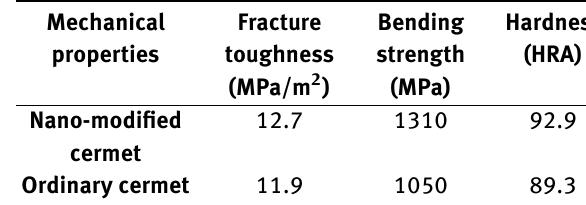
Table 1: Mechanical properties of nano-modified cermet and